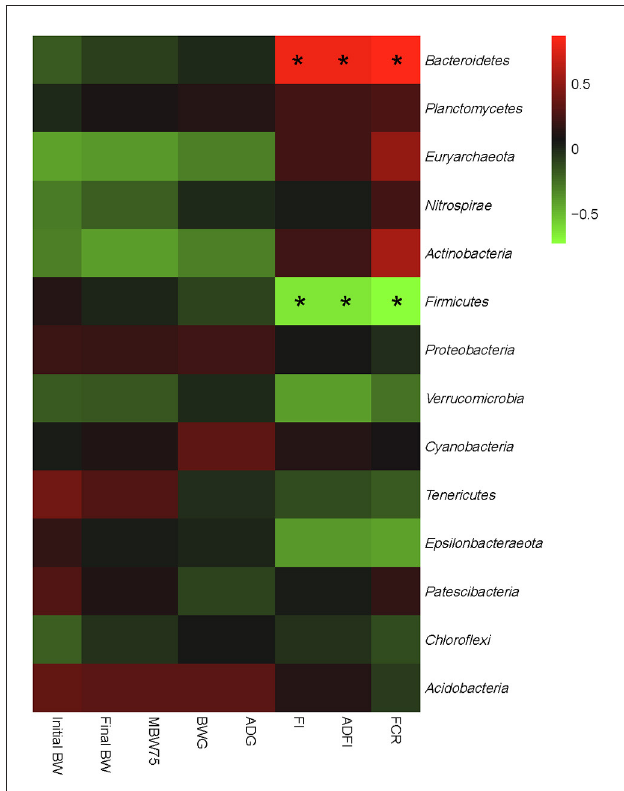
FIGURE4 Correlation analysis of relative abundances of cecal bacteria and growth performance of both low- and high-residue feed intake ducks at the phylum level. The red color represents a positive correlation, while the blue color represents a negative correlation. “*” denotes a significant correlation (|r| > 0.55, P < 0.05). Initial BW, body weight on day 22; final BW, body weight on day 56; MBW 0.75 , metabolic body weight on day 56; ADG, average daily gain; ADFI, average daily feed intake; FCR, feed conversion ratio; RFI, residual feed